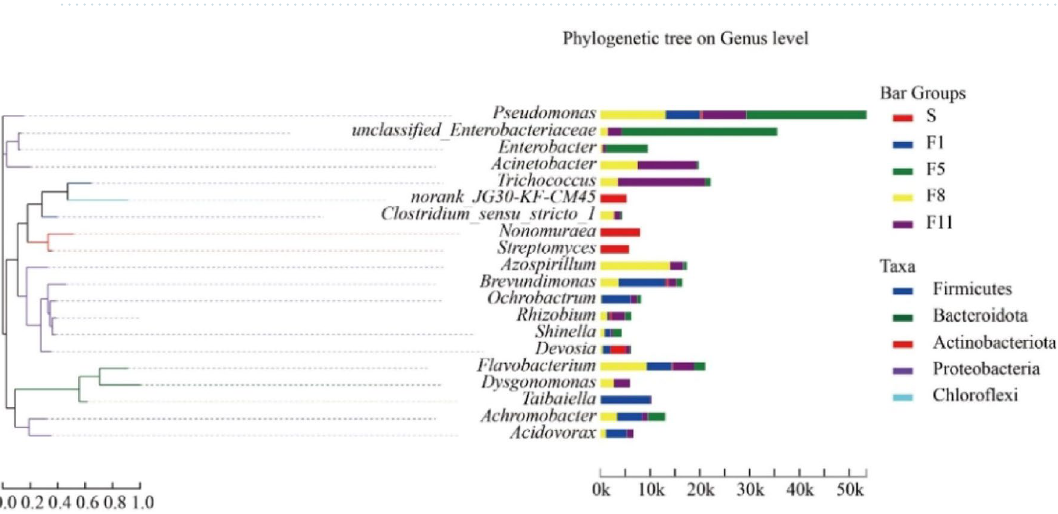
Figure 8. Microbial biological phylogenetic tree on the genus